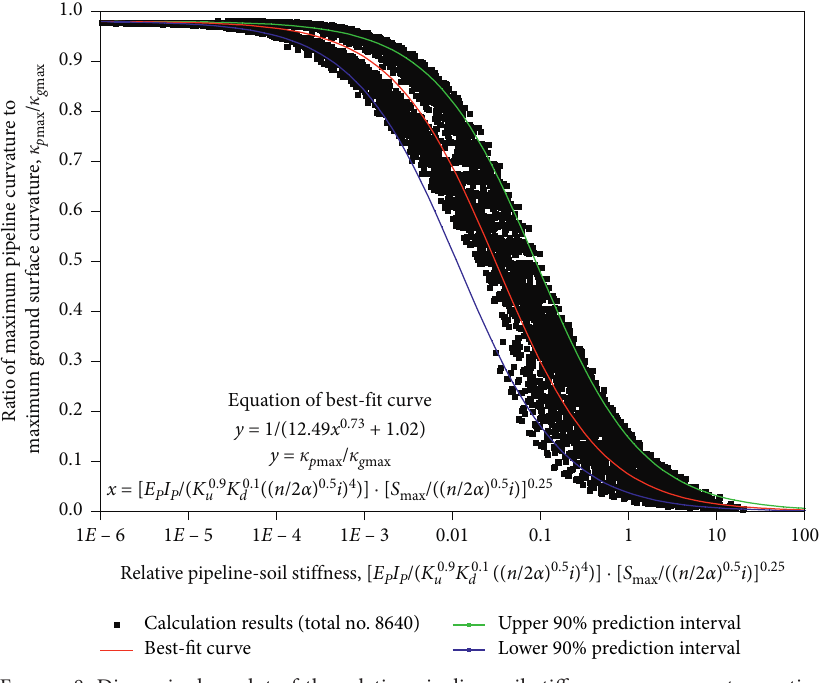
Figure 8: Dimensionless plot of the relative pipeline-soil stiffness versus curvature